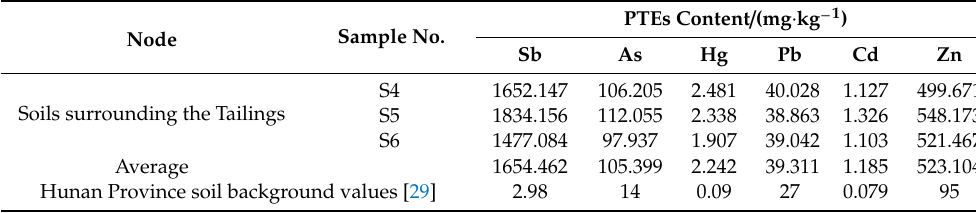
Table 4. PTEs’ contents in soil samples surrounding antimony tailings.